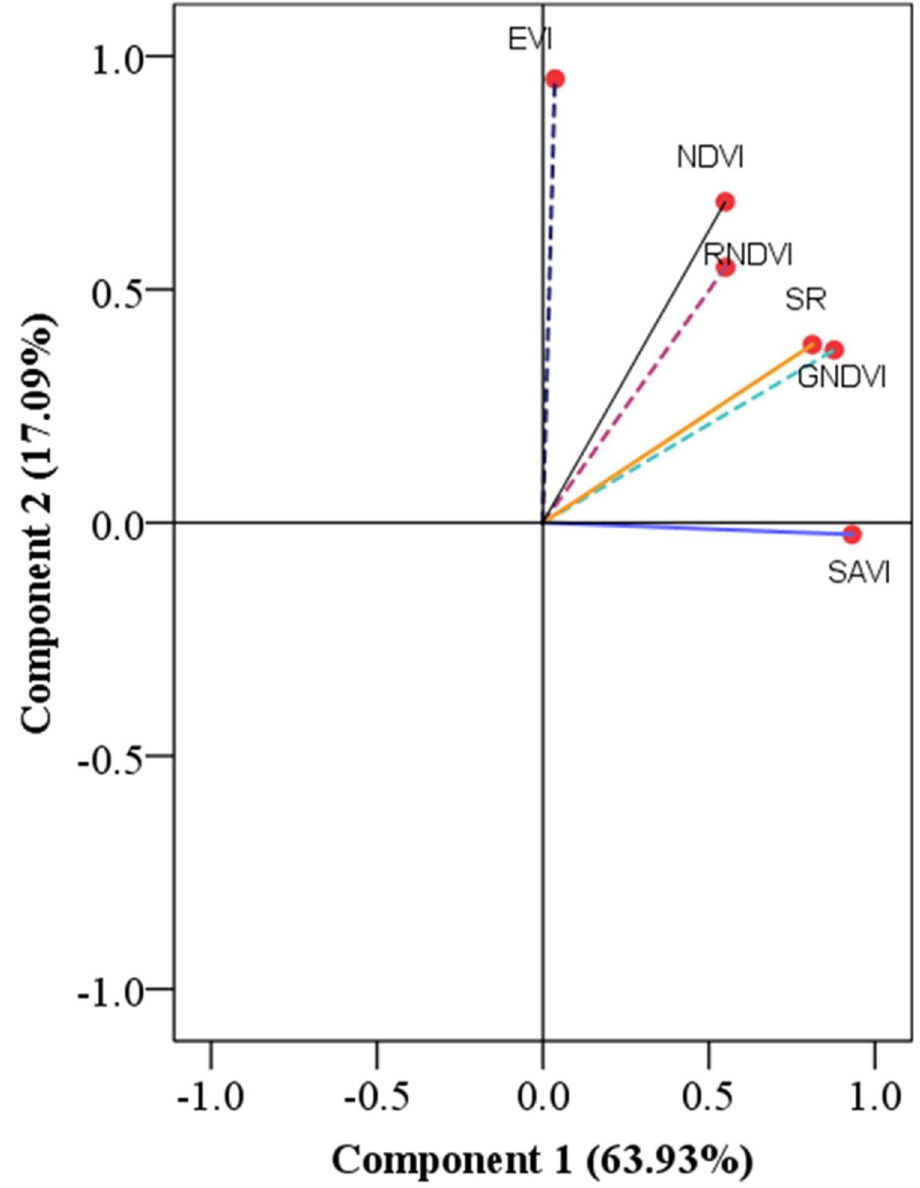
Fig 3. Rotated components of loading of the vegetation indices of maize. EVI enhanced vegetation index; NDVI normalized difference vegetation index; GNDVI green normalized difference vegetation index; RNDVI Red normalized difference vegetation index; SR simple ratio; SAVI soil-adjusted vegetation